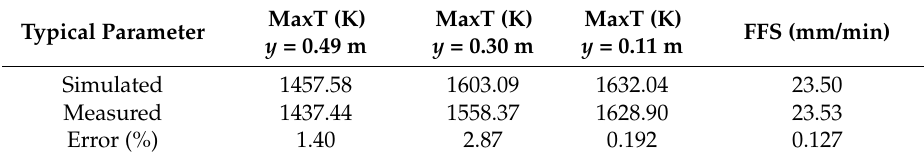
Table 5. Comparison between the simulated and measured